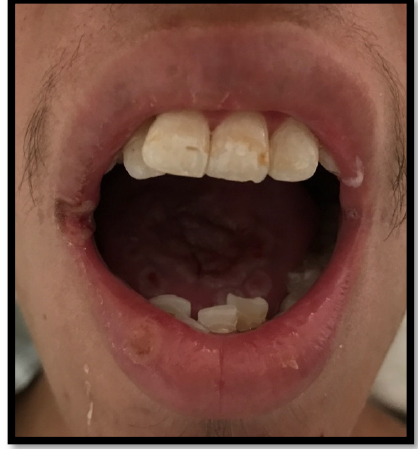
Figure 3. Angular cheilitis.